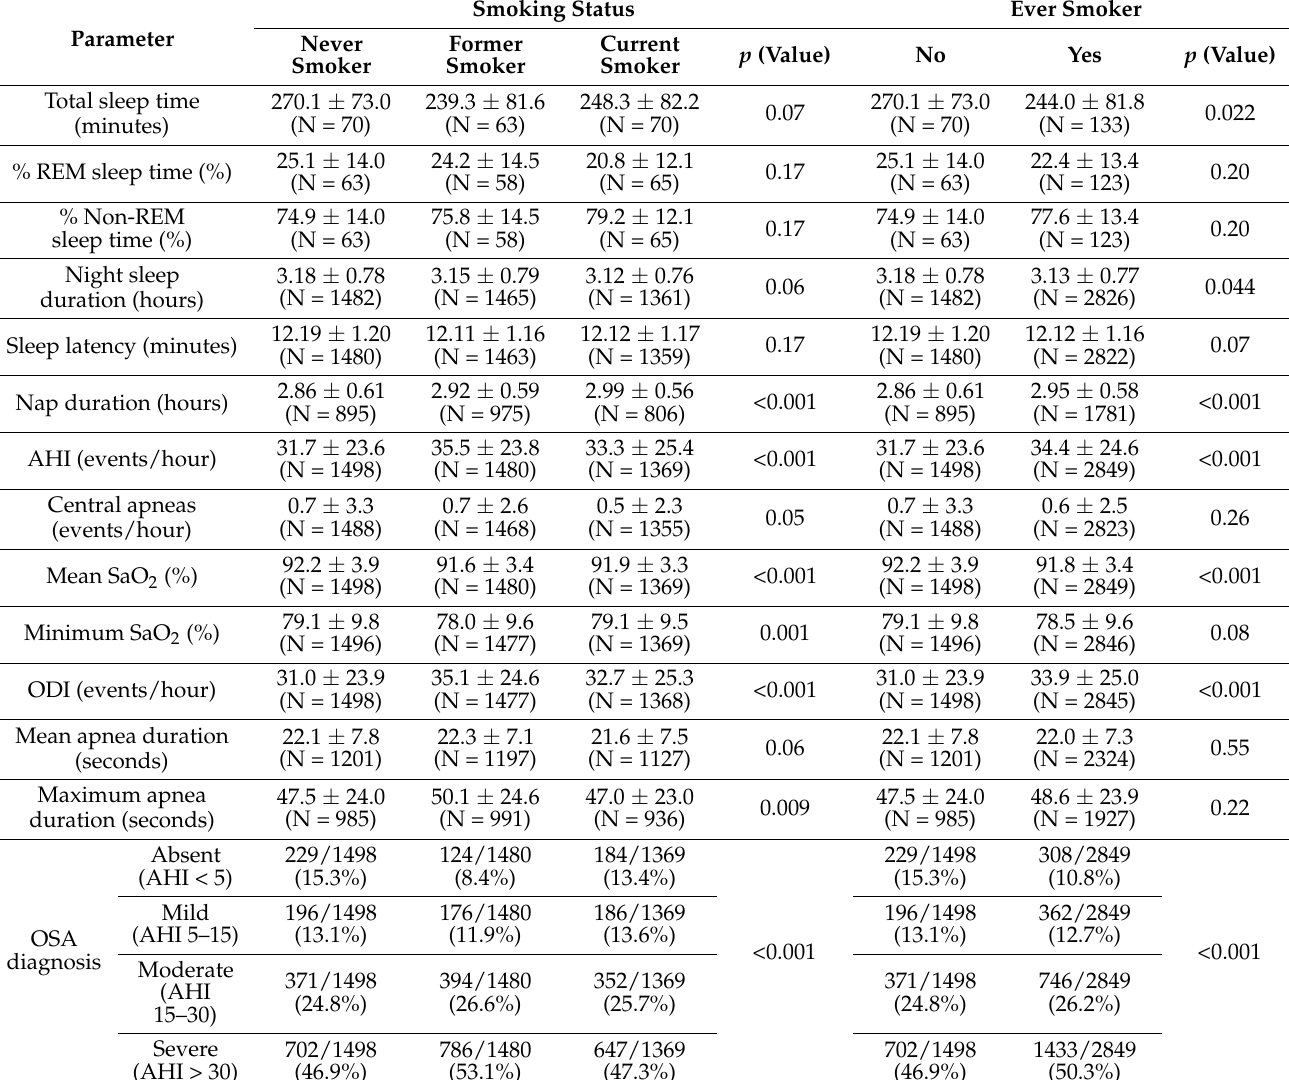
Table 5. Sleep study parameters according to the smoking status of the